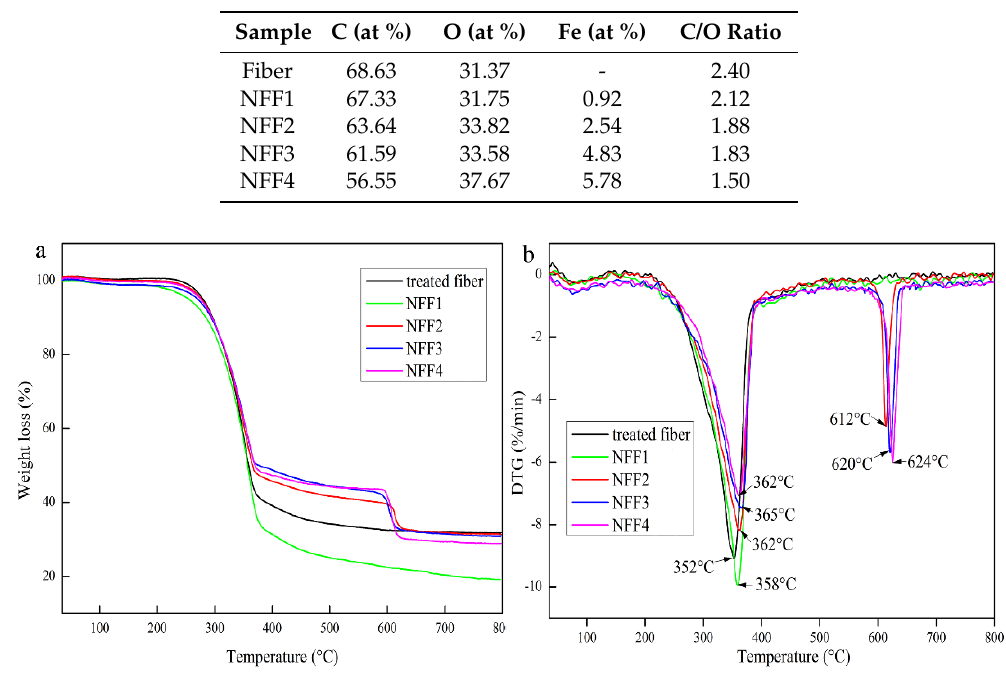
Table 1. Element content and C/O atomic ratio of fiber and nano-Fe 3 O 4 /Fiber (NFF) composite. Sample C (at %) O (at %) Fe (at %)